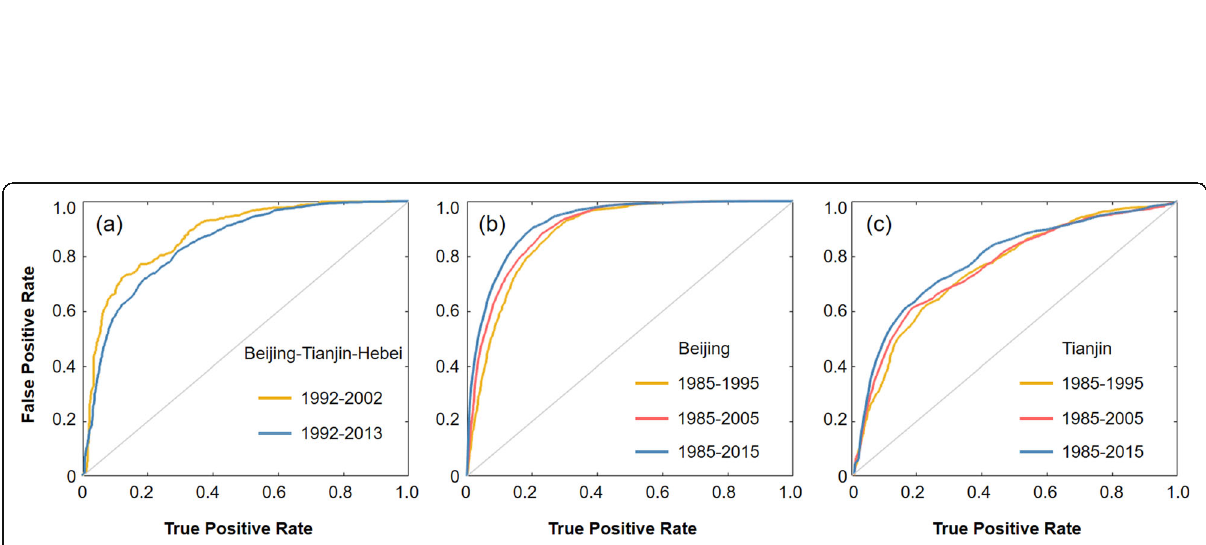
Fig. 9 Performance (i.e., ROC curves) of derived suitability surfaces using training samples collected in different periods in the Beijing-Tianjin- Hebei region at the 1-km spatial resolution ( a ) and in Beijing ( b ) and Tianjin ( c ) at the 30-m spatial resolution. The suitability surface with a ROC curve in the upper-left corner indicates a good